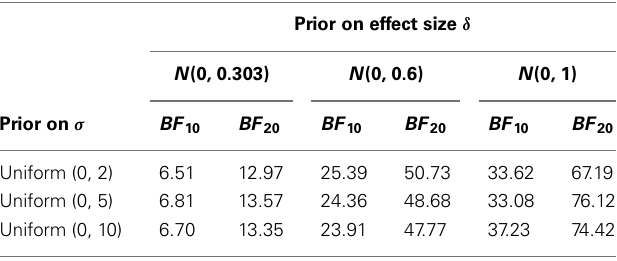
Table 3 | Results of a sensitivity analysis for the surname cities data